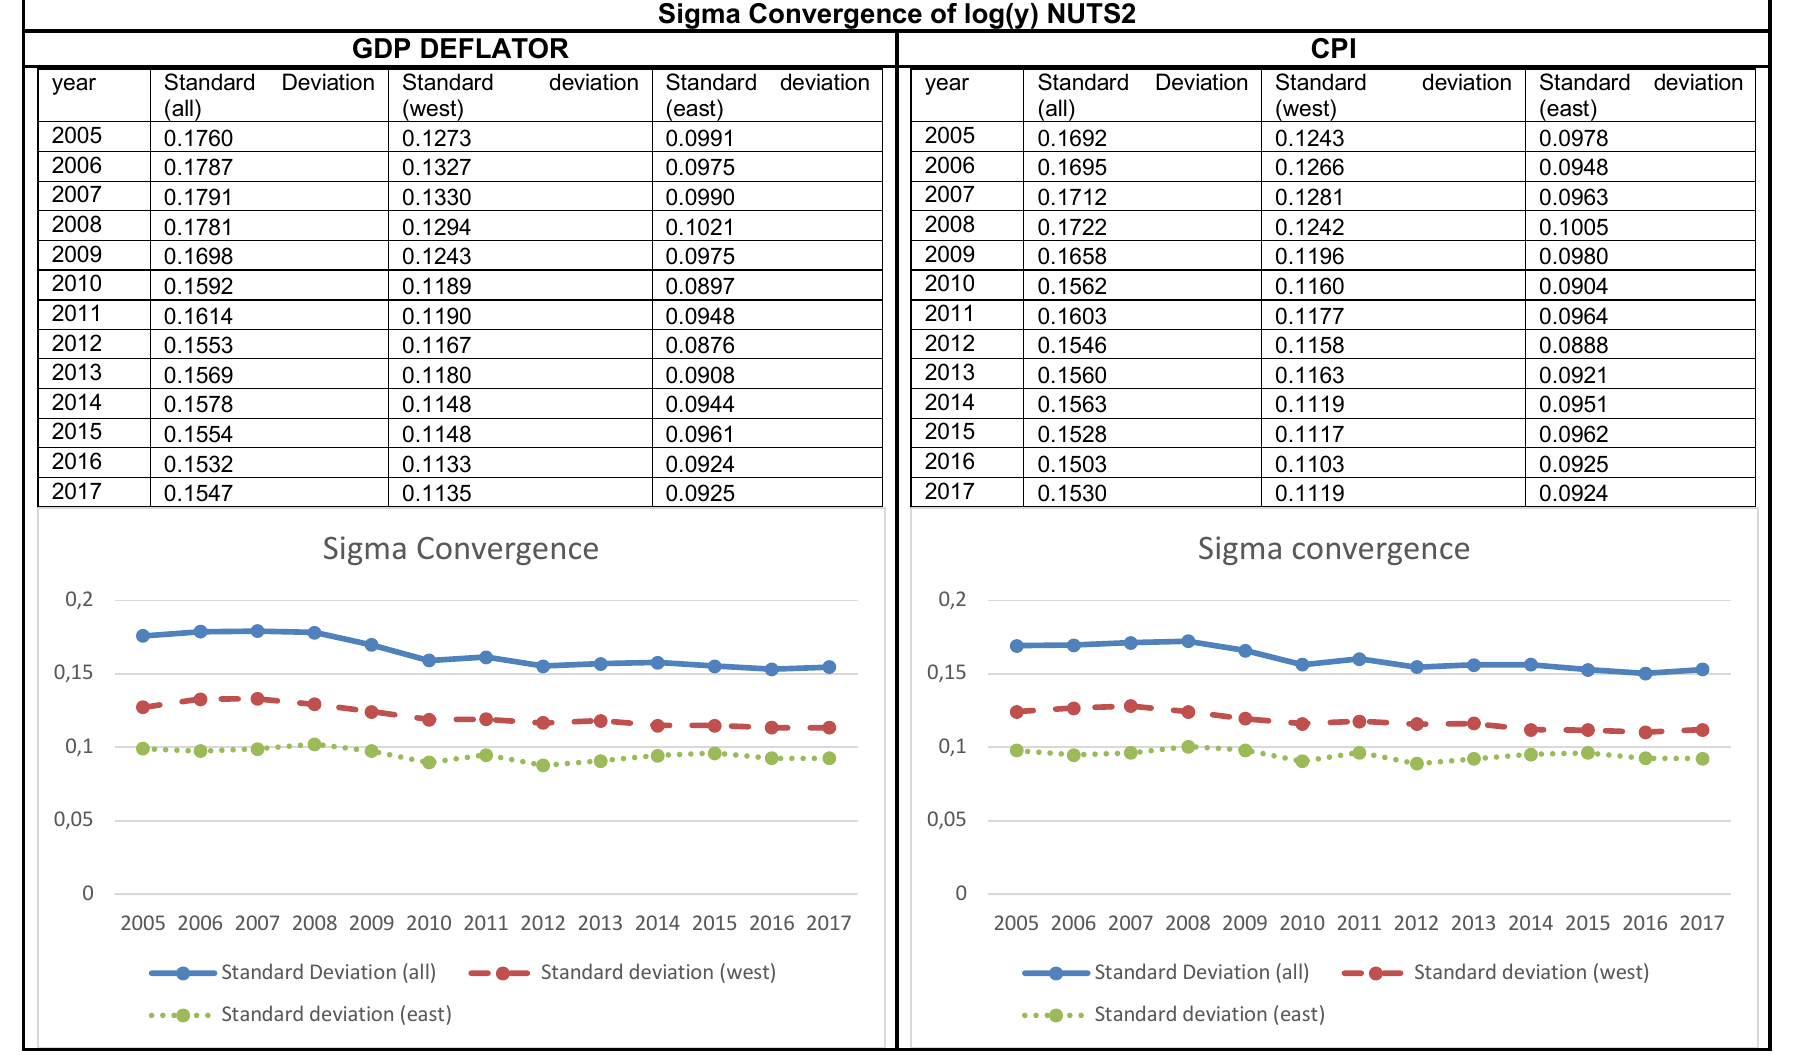
Table A.3: Comparison between GDP Deflator and CPI (2005-2017) (3) Sigma Convergence of log(y) NUTS2 GDP